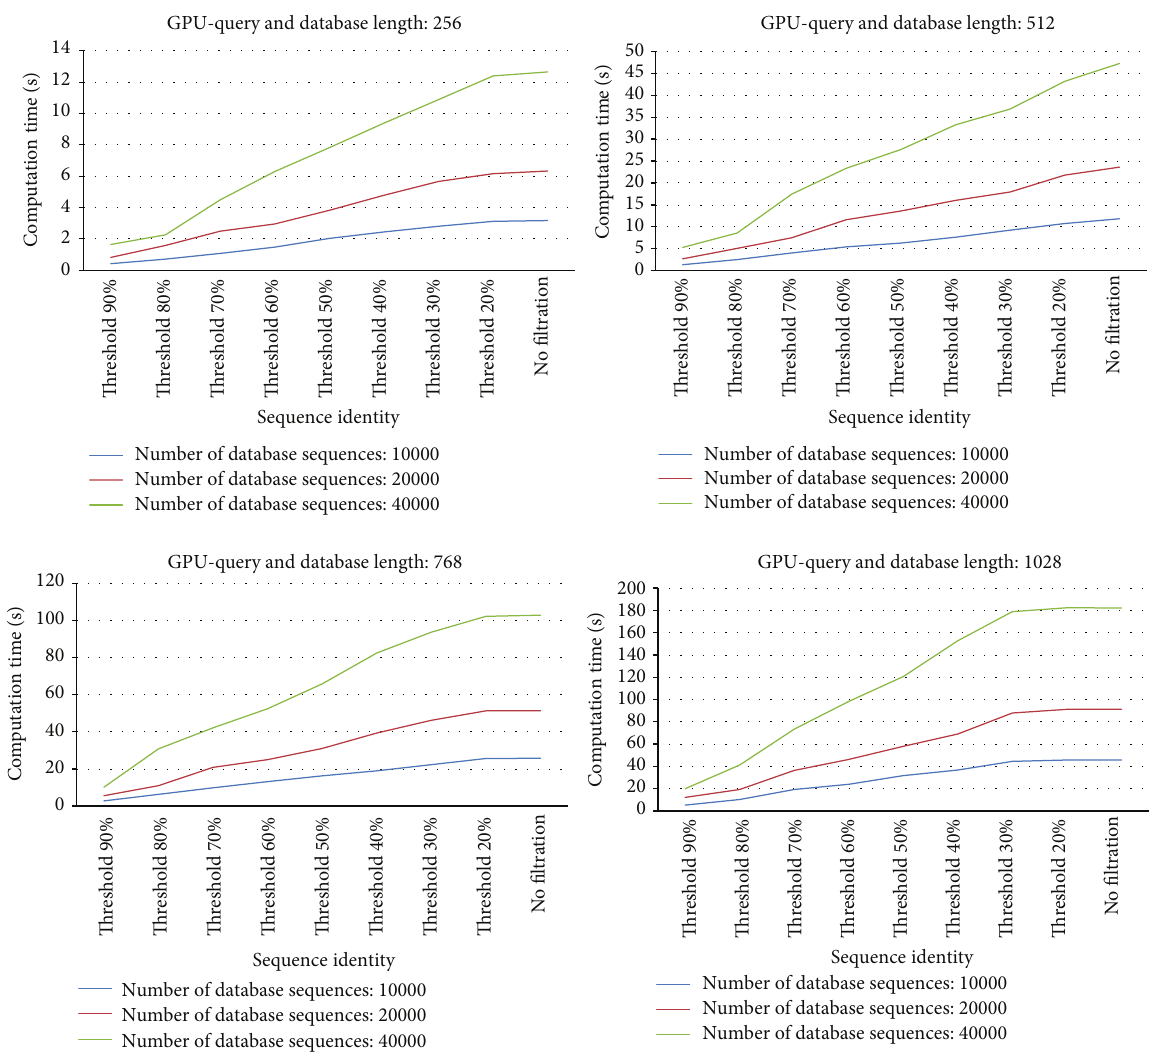
Figure 3: The overall computation time by CUDA-SWfr with various thresholds for 12 synthetic